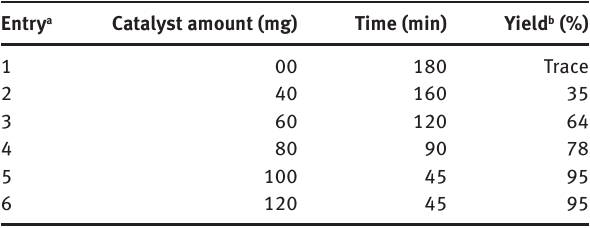
a Reaction condition: 4-bromobenzaldehyde (1 mmol), 2-amino thio- phenol (1 mmol), MoO nanorods. 3 b Isolated yield.